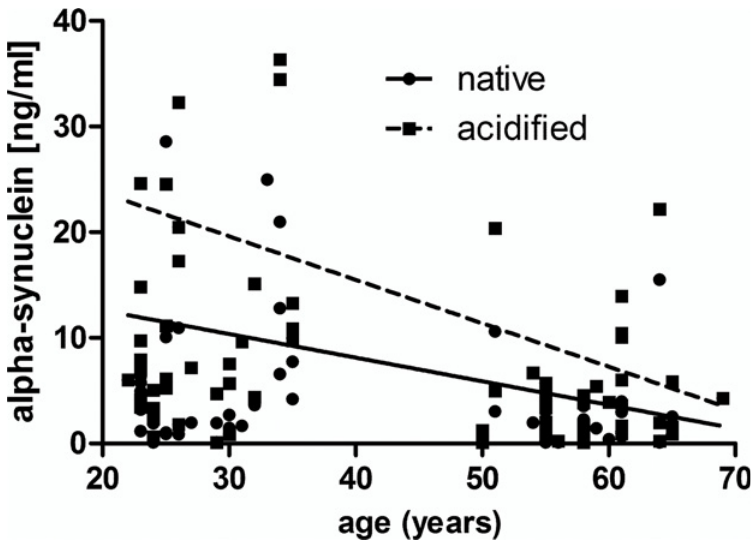
Fig 8. Linear regression of age with alpha-synuclein concentration in native and acidified plasma. Alpha-synuclein decreased with age and was enhanced by acidification. Spearman correlation was very significant for native samples, p = 0.0093, r = -0.3, after acidification, p = 0.0019, r = -0.34.